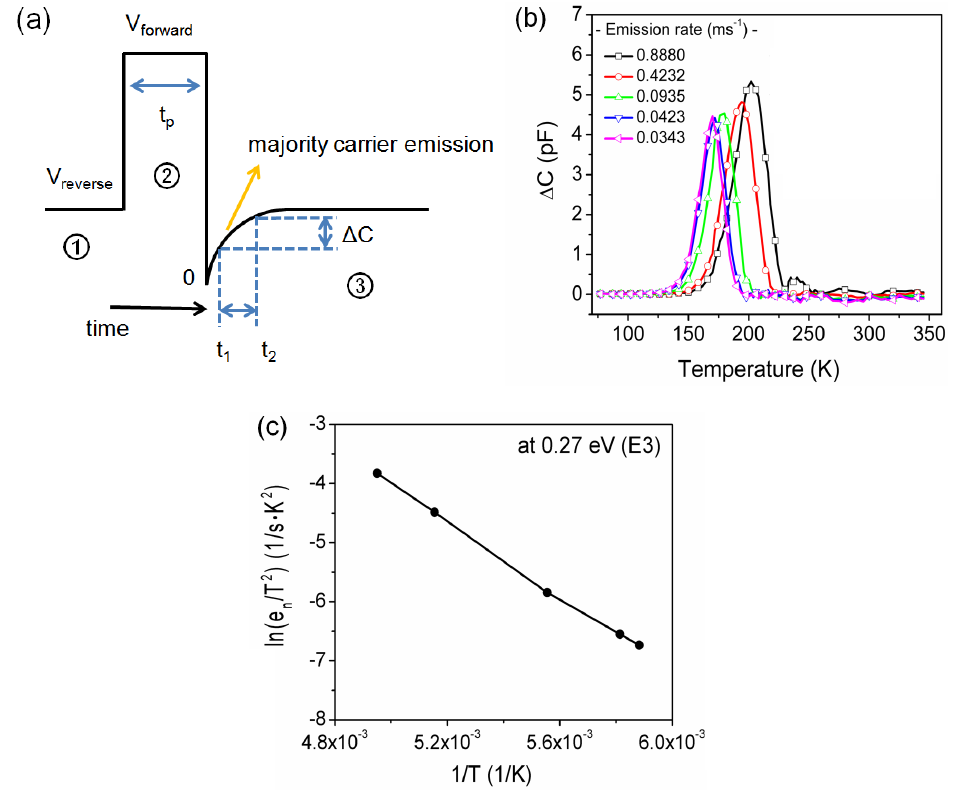
Figure 4. (Color online) ( a ) Applied voltage and resultant transient capacitance; ( b ) DLTS spectra